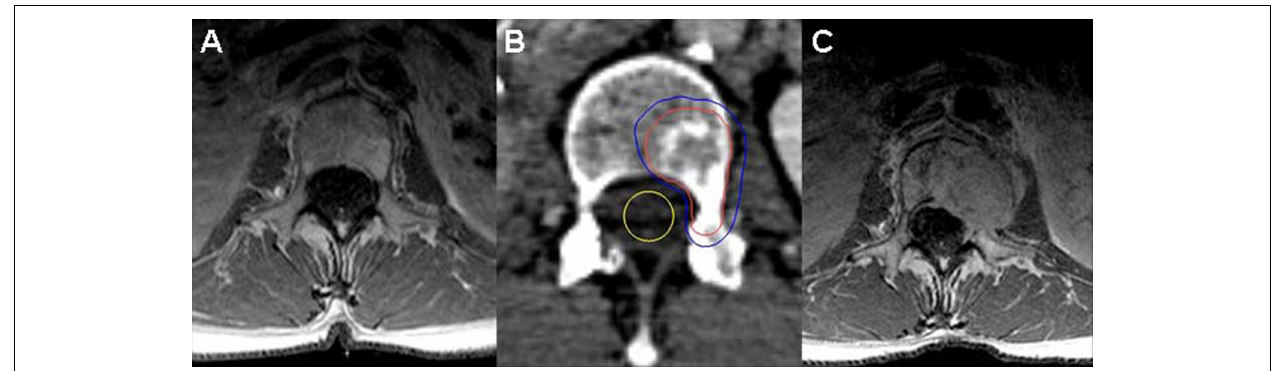
FIGURE 4 | (A) Solitary L1 liposarcoma metastasis; (B) CyberKnife treatment plan dose distribution with gross tumor volume shown in red and the 35 Gy isodose line in blue; and (C) MRI at 14 months post-treatment with local recurrence.